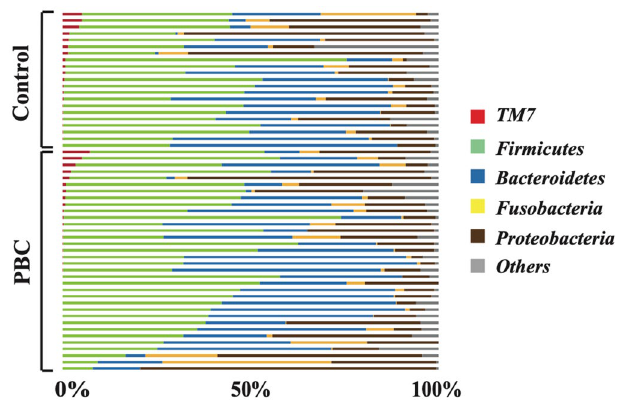
Figure 2. Differences in characterized MAM between patients with PBC and HCs at the phylum level. Bacterial composition at phylum level. The relative amount of bacterial composition at the phylum level is shown in a bar graph for each sample obtained from the PBC and HC groups. MAM, mucosa-associated microbiota; PBC, primary biliary cholangitis; HC, healthy